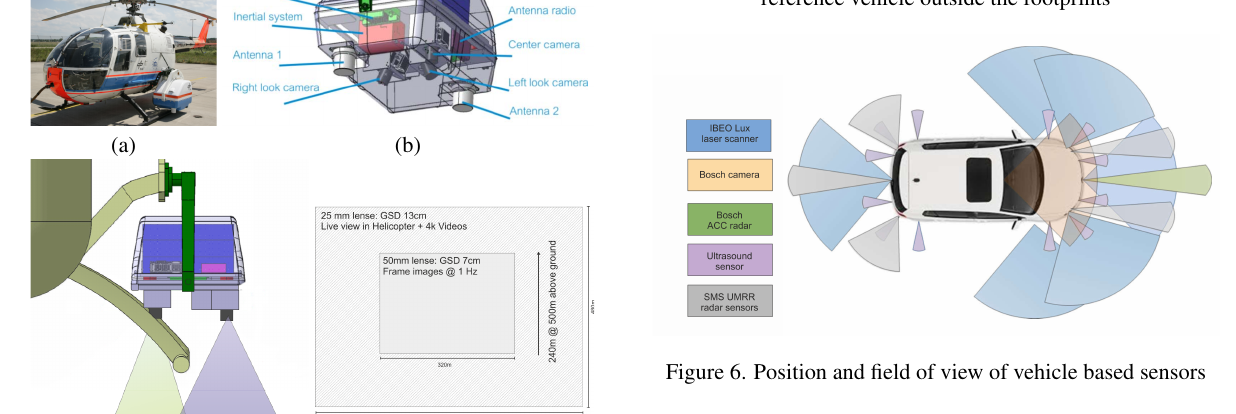
Figure 5. Completeness of image acquisition (examples) on motorways (a) and over the city (b); green and yellow dots indicate the reference vehicle within the footprint of the camera with 50mm resp. 25mm lense; gaps (in red) indicate the reference vehicle outside the footprints